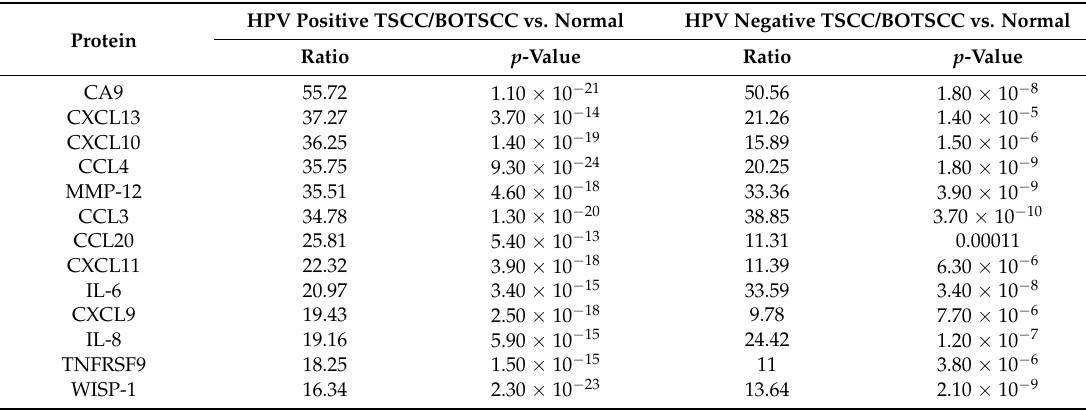
Table 2. Proteins with the most prominent differences between TSCC/BOTSCC and normal